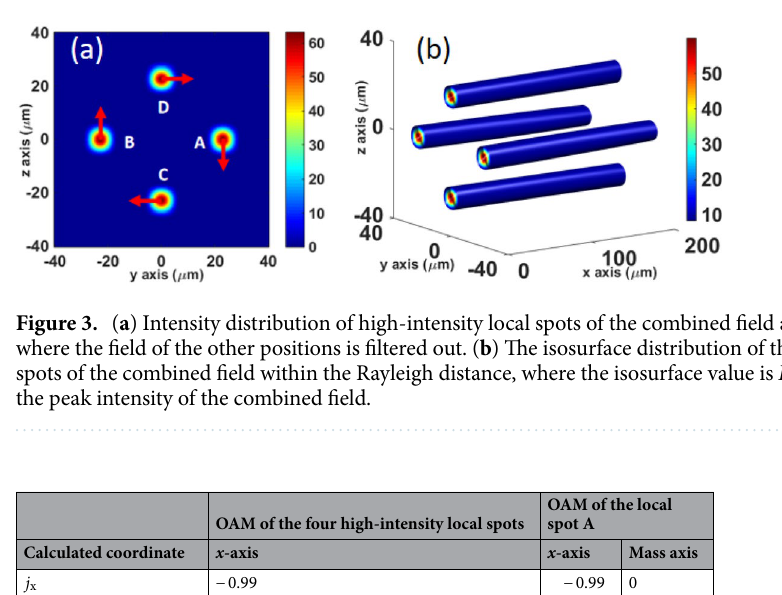
OAM of the four high-intensity local spots Calculated coordinate x -axis x -axis Mass axis